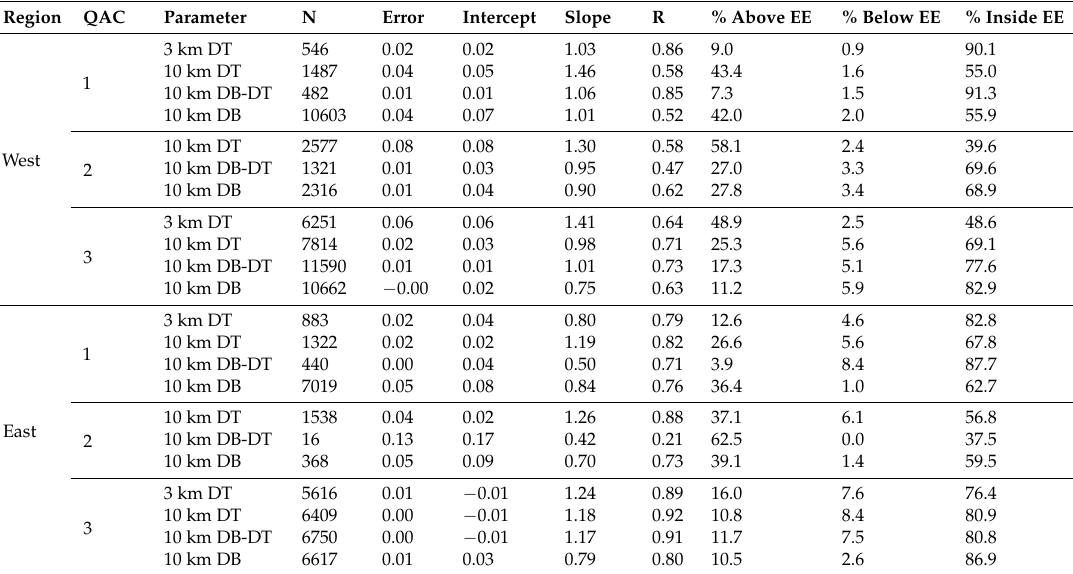
Table 2. Performance statistics for each AOD